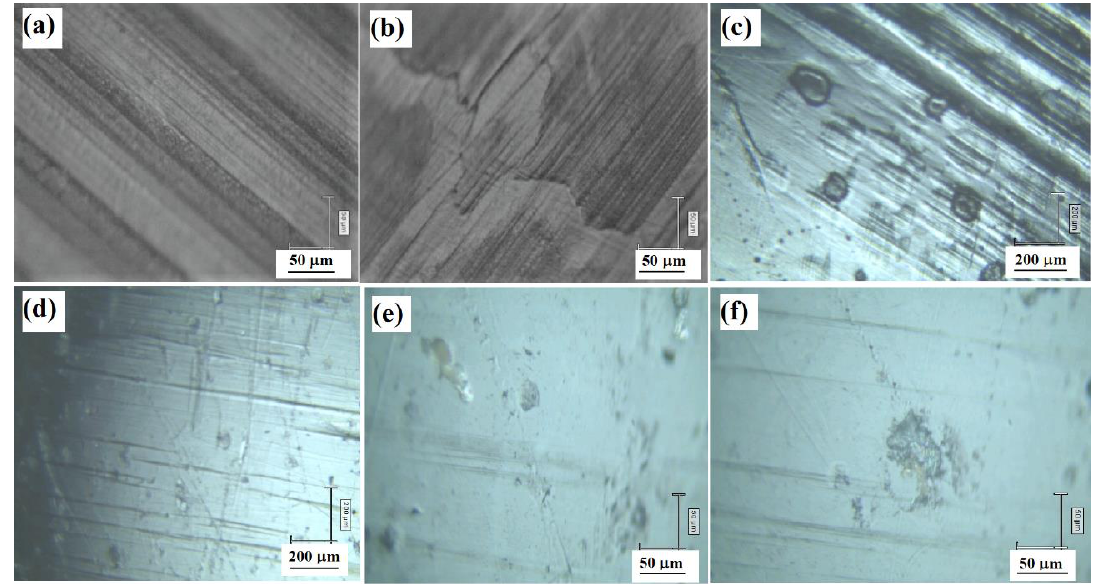
Figure 5. Micrographs recorded in real time on the surface of UHMWPE component during Raman measurements. ( a , b ) New (unused) UHMWPE component at the interface with ( a ) tibial and ( b ) femoral sites, respectively; ( c – f ) retrieved UHMWPE component—the interface with ( c ) femoral and ( d ) tibial sites, respectively; ( e , f ) persistent organic spots detected on the interface.